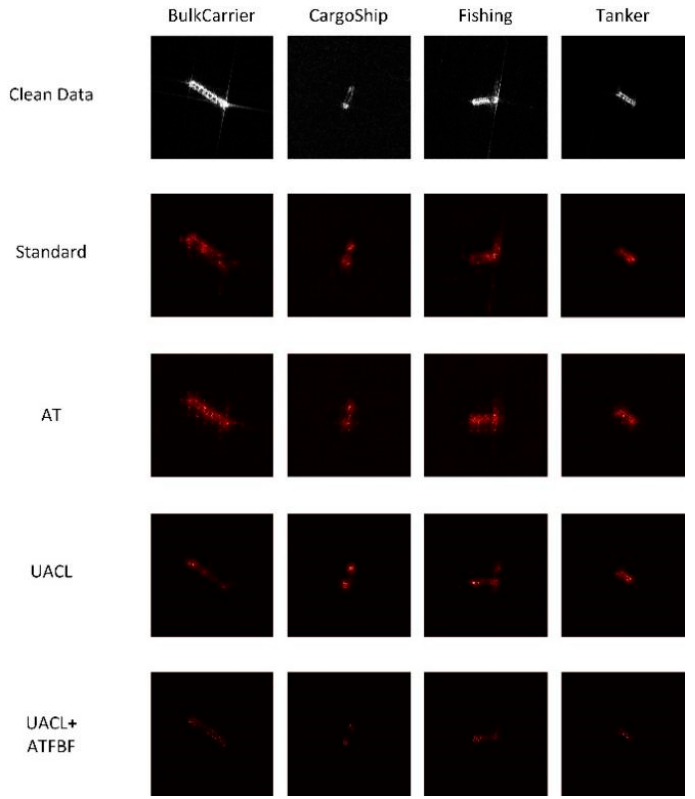
Figure 11. Guided backpropagation images of FUSAR-Ship model in the classification of clean data.